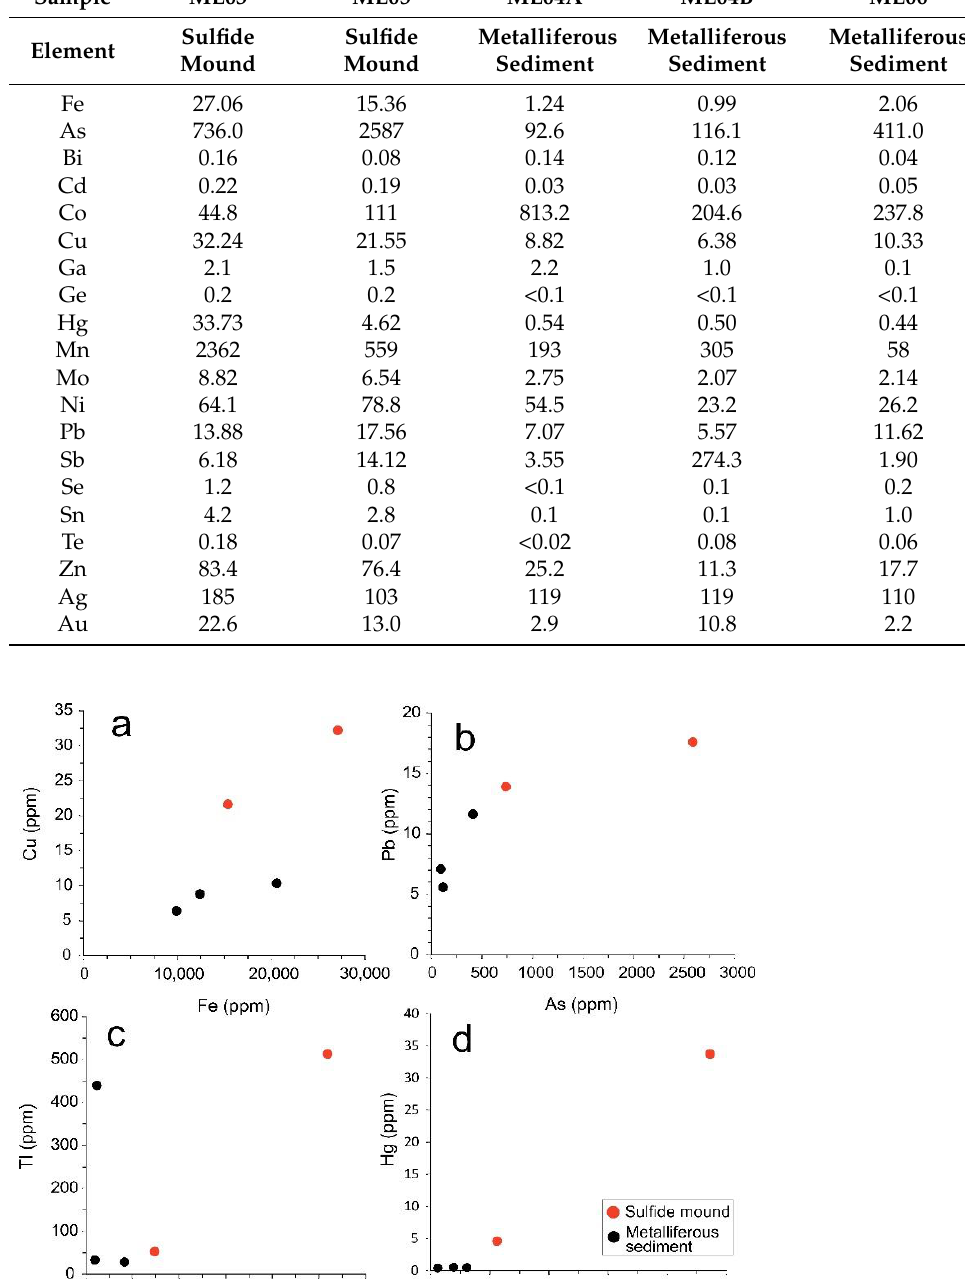
Table 2. Bulk ore analyses (ICP‐MS) of sulfide samples from Paleochori Bay. Iron in wt %, Au and Ag in ppb, and all other elements in ppm. Sample numbers, as in Figure 4 and Table 1.